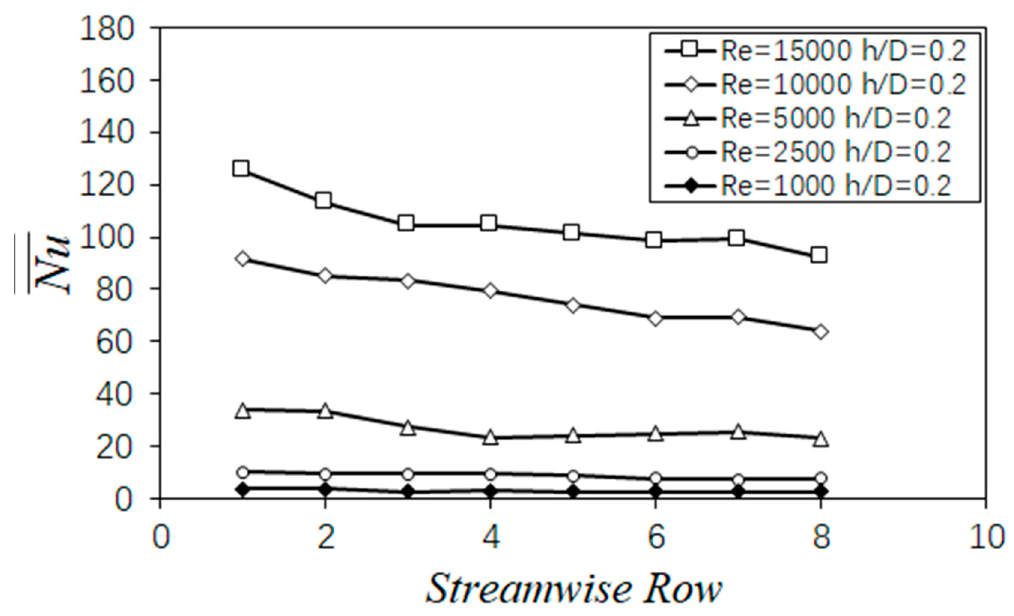
Figure 16. Spatially averaged Nusselt numbers as dependent on streamwise row location, for different Re j , for micro cooling units height of 0.2 D.